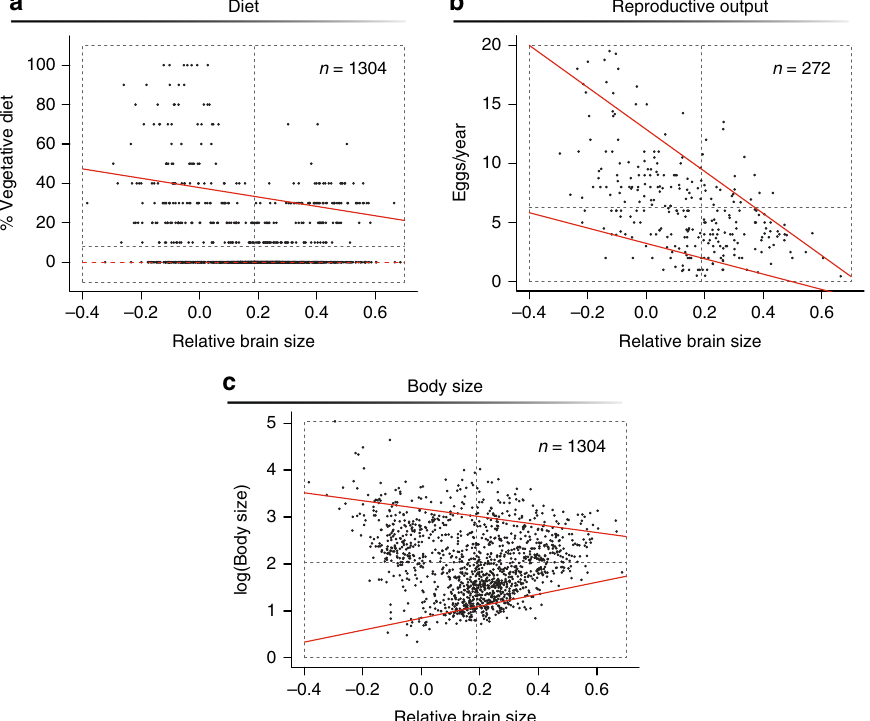
Fig. 3 Constraints imposed by relative brain size on additional traits. For the global sample of resident species, quantile regression with τ = 0.9 and τ = 0.1 was used to test whether upper or lower values of diet ( a ), reproductive output ( b ), and body size ( c ) change with relative brain size; slopes that differ signi fi cantly from zero are indicated with a solid red line, those that do not with a dashed red line. For reference, dotted gray lines show the mean value for each trait and de fi ne the quadrants used in the analyses depicted in Fig. 4. Source data are provided as a Source Data fi